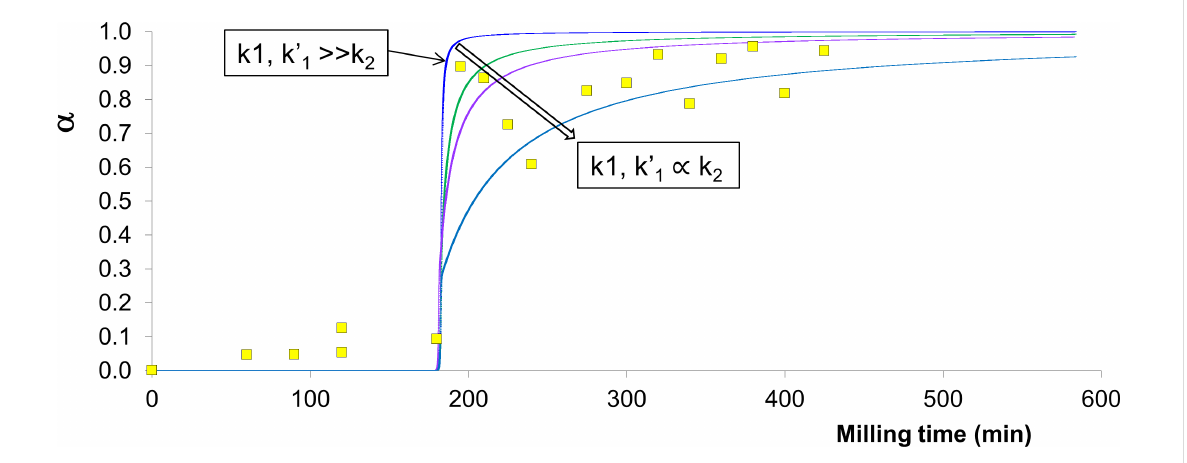
Figure 3: Modelled kinetic profiles for 15 Hz neat milling, with variation in the magnitude of the mixing term. Experimental data points for NG at 15 Hz are provided as yellow squares. Note that no parameters in the model are fit from experiment.